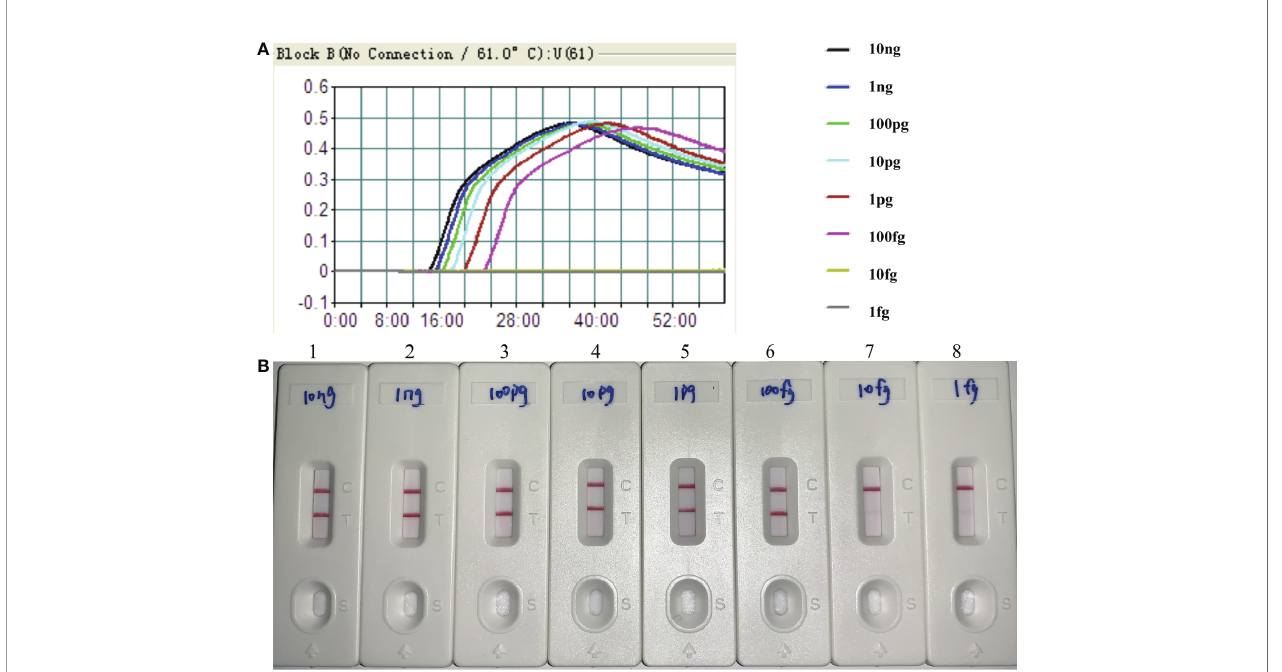
FIGURE 4 | Sensitivity of H . in fl uenzae- MCDA-LFB assay with serially diluted genomic DNA templates. Two measurement assays, namely, real-time turbidity (A) and later fl ow biosensor (B) , were applied for detecting MCDA products. The serial dilutions of target DNA templates (10 ng, 1 ng, 100 pg, 10 pg, 1 pg, 100 fg, 10 fg, and 1 fg) were used for sensitivity analysis. Turbidity signals (A) / Biosensors (B) 1 – 8, respectively, represent the DNA levels of 10 ng, 1 ng, 100 pg, 10 pg, 1 pg, 100 fg, 10 fg, and 1 fg per reaction. The DNA levels of 10 ng, 1 ng, 100 pg, 10 pg, 1 pg, 100 fg per reaction generated the positive